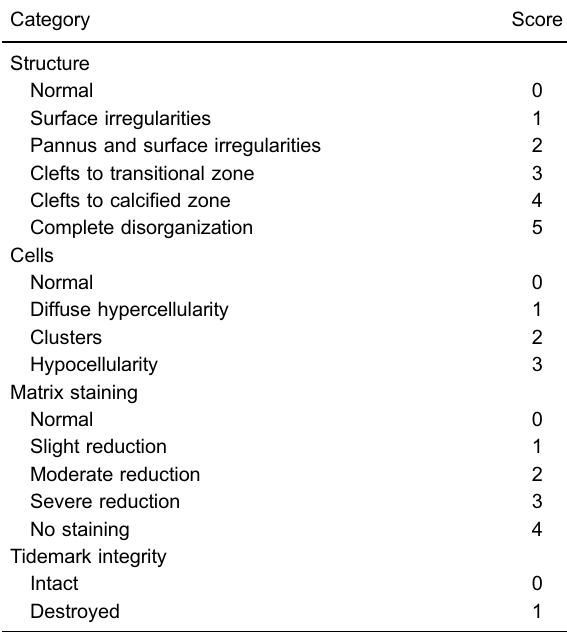
Table 1. Modi fi ed Mankin histological